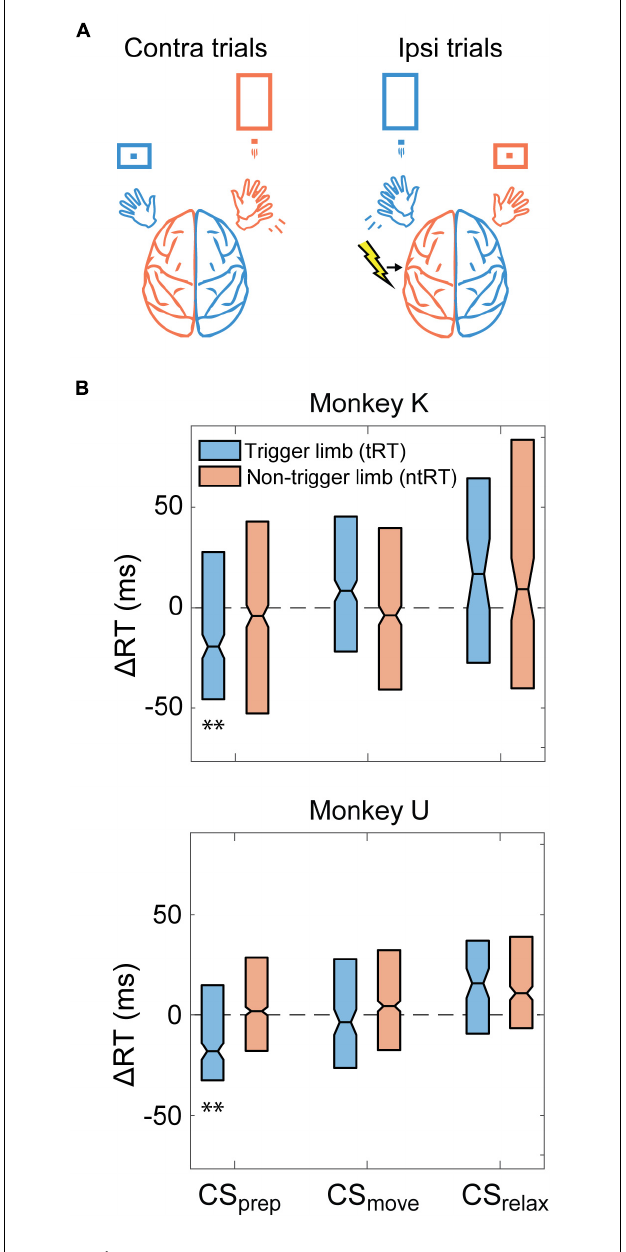
FIGURE 5 | Ipsilateral CS. (A) Example illustration of Ipsilateral CS and task relationship for left hemispheric stimulation. (B) Difference between RTs for trials during the Cond epoch and the median RT of the Pre epoch for each monkey. CS prep decreased tRT in both monkeys. Significance is calculated in comparison with the no stimulation control experiments and only denoted if consistent across both animals ( ∗∗ p < 0.001). (cid:0) (cid:1) where C xy is the coherence between x and y , P xy is the cross- f (cid:0) (cid:1) spectral density between x and y , and P xx and P yy ( f ) are the f spectral densities of x and y respectively. In all coherence analyses, x and y were signals from electrodes in different hemispheres. Coherence traces in figures are the average of all pairwise combinations of electrodes between the two